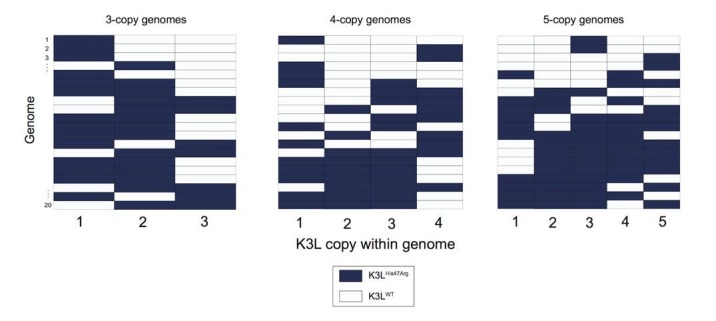
Variety of mixed vaccinia genomes in P15 sequencing data.We selected a random set of 20 vaccinia genomes of the specified copy number from the P15 sequencing data (a passage with a large proportion of mixed genomes), and plotted the distribution of K3LHis47Arg and K3LWT alleles within each genome.